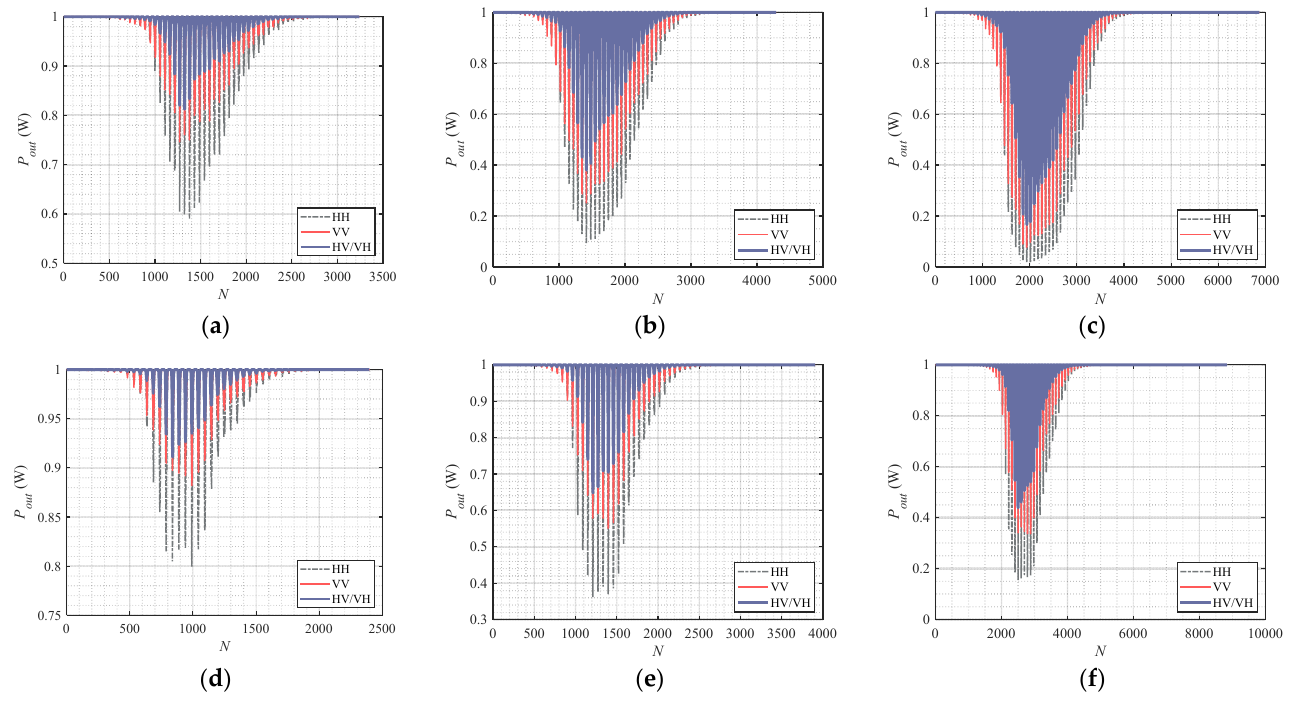
Figure 12. Attenuation coefficients for each resolution cell of chaff clouds with different number of elements. ( a ) 5 GHz, N = 1,000,000; ( b ) 5 GHz, N = 5,000,000; ( c ) 5 GHz, N = 10,000,000; ( d ) 10 GHz, N = 1,000,000; ( e ) 10 GHz, N = 5,000,000; ( f ) 10 GHz, N = 10,000,000.